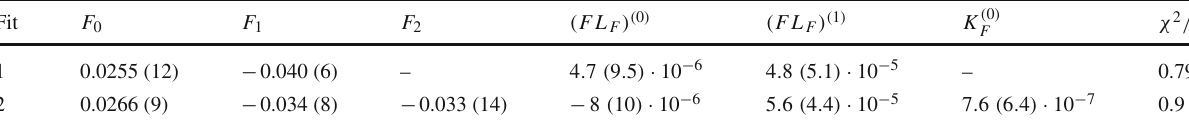
Table 6 Different fits for the decay constant as described in the text